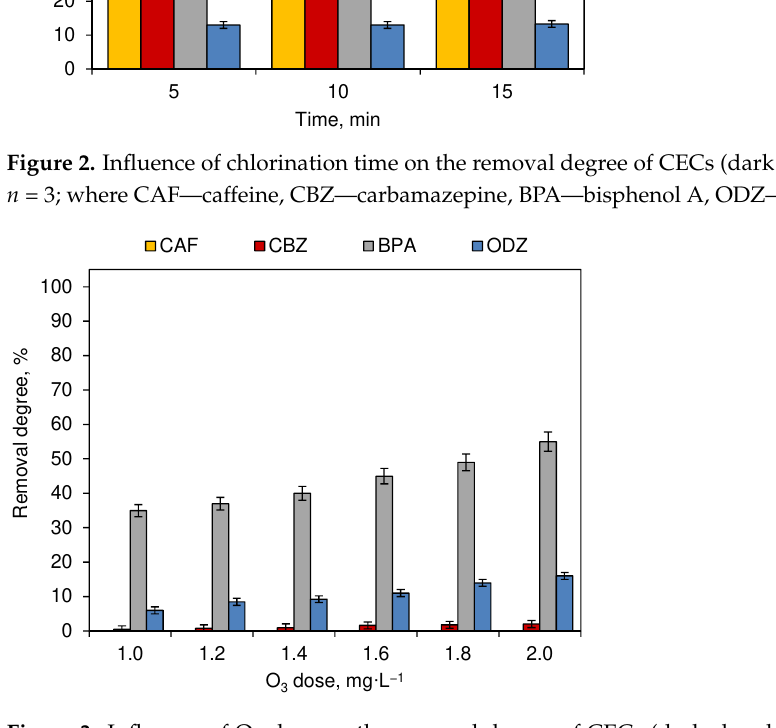
Figure 2. Influence of chlorination time on the removal degree of CECs (dark chamber experiment; n = 3; where CAF—caffeine, CBZ—carbamazepine, BPA—bisphenol A, ODZ—oxadiazon).